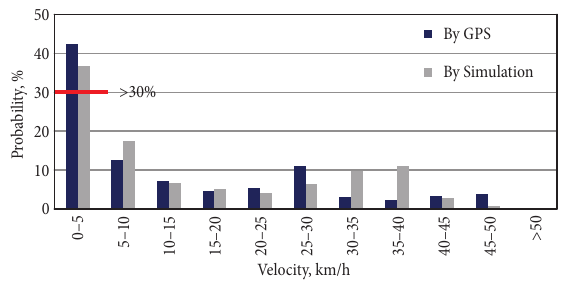
Fig. 7. The example of velocity distribution